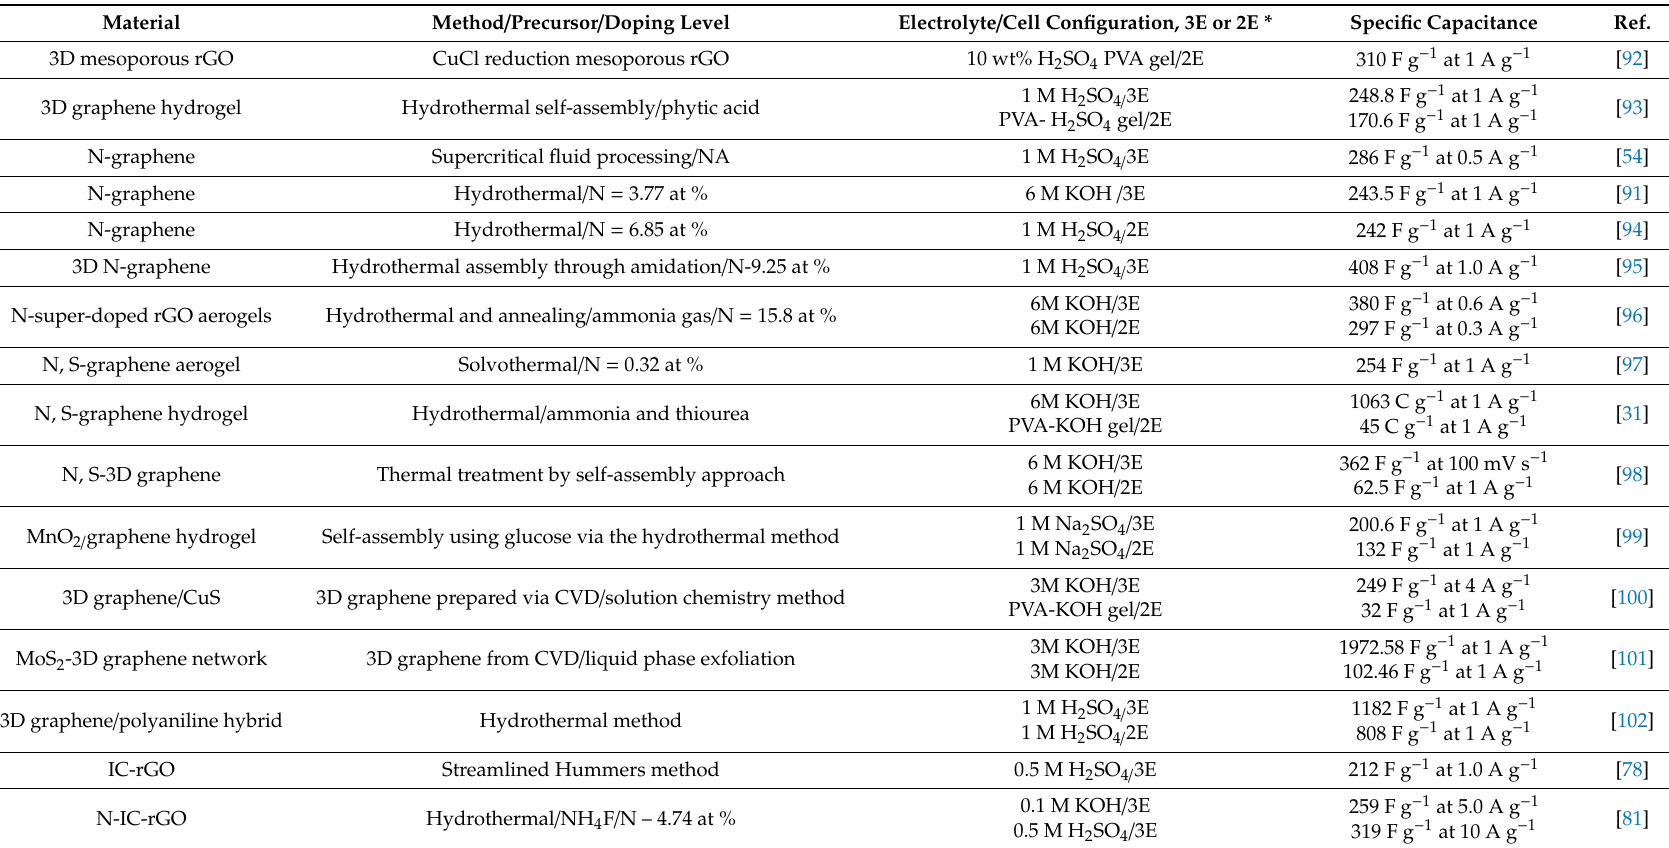
Table 2. Comparison of 3D-GNMs as electrode materials for supercapacitor applications. CVD: chemical vapor